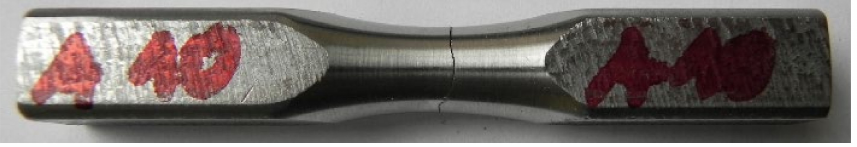
Figure 2. The geometry of a test piece used to test 16Mo3 steel under oscillatory bending